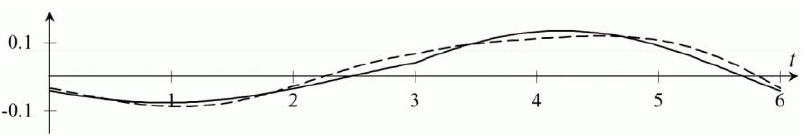
Figure 1. Graphs of 𝑢 1 (𝑡) (solid line) and 𝑢 2 (𝑡) (dashed line). The graphs of the functions 𝑉 1 (𝑡) and 𝑉 2 (𝑡) are shown in Figure 2.